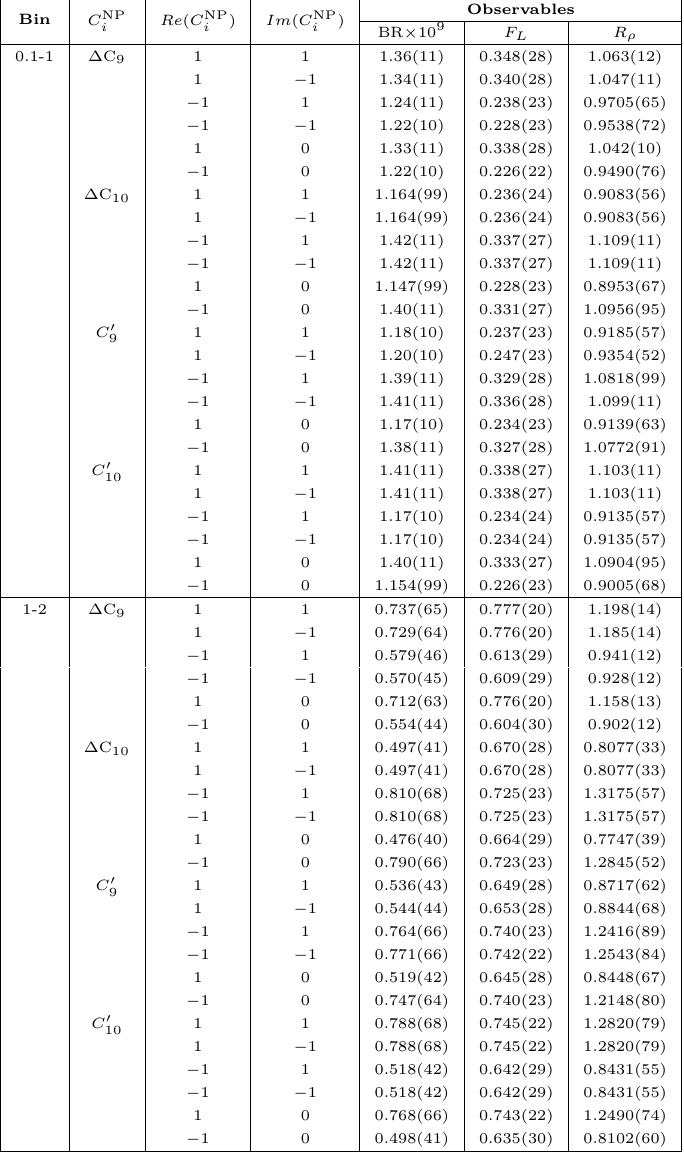
for the q 2 bins 0 . 1 − 1 9 , 10